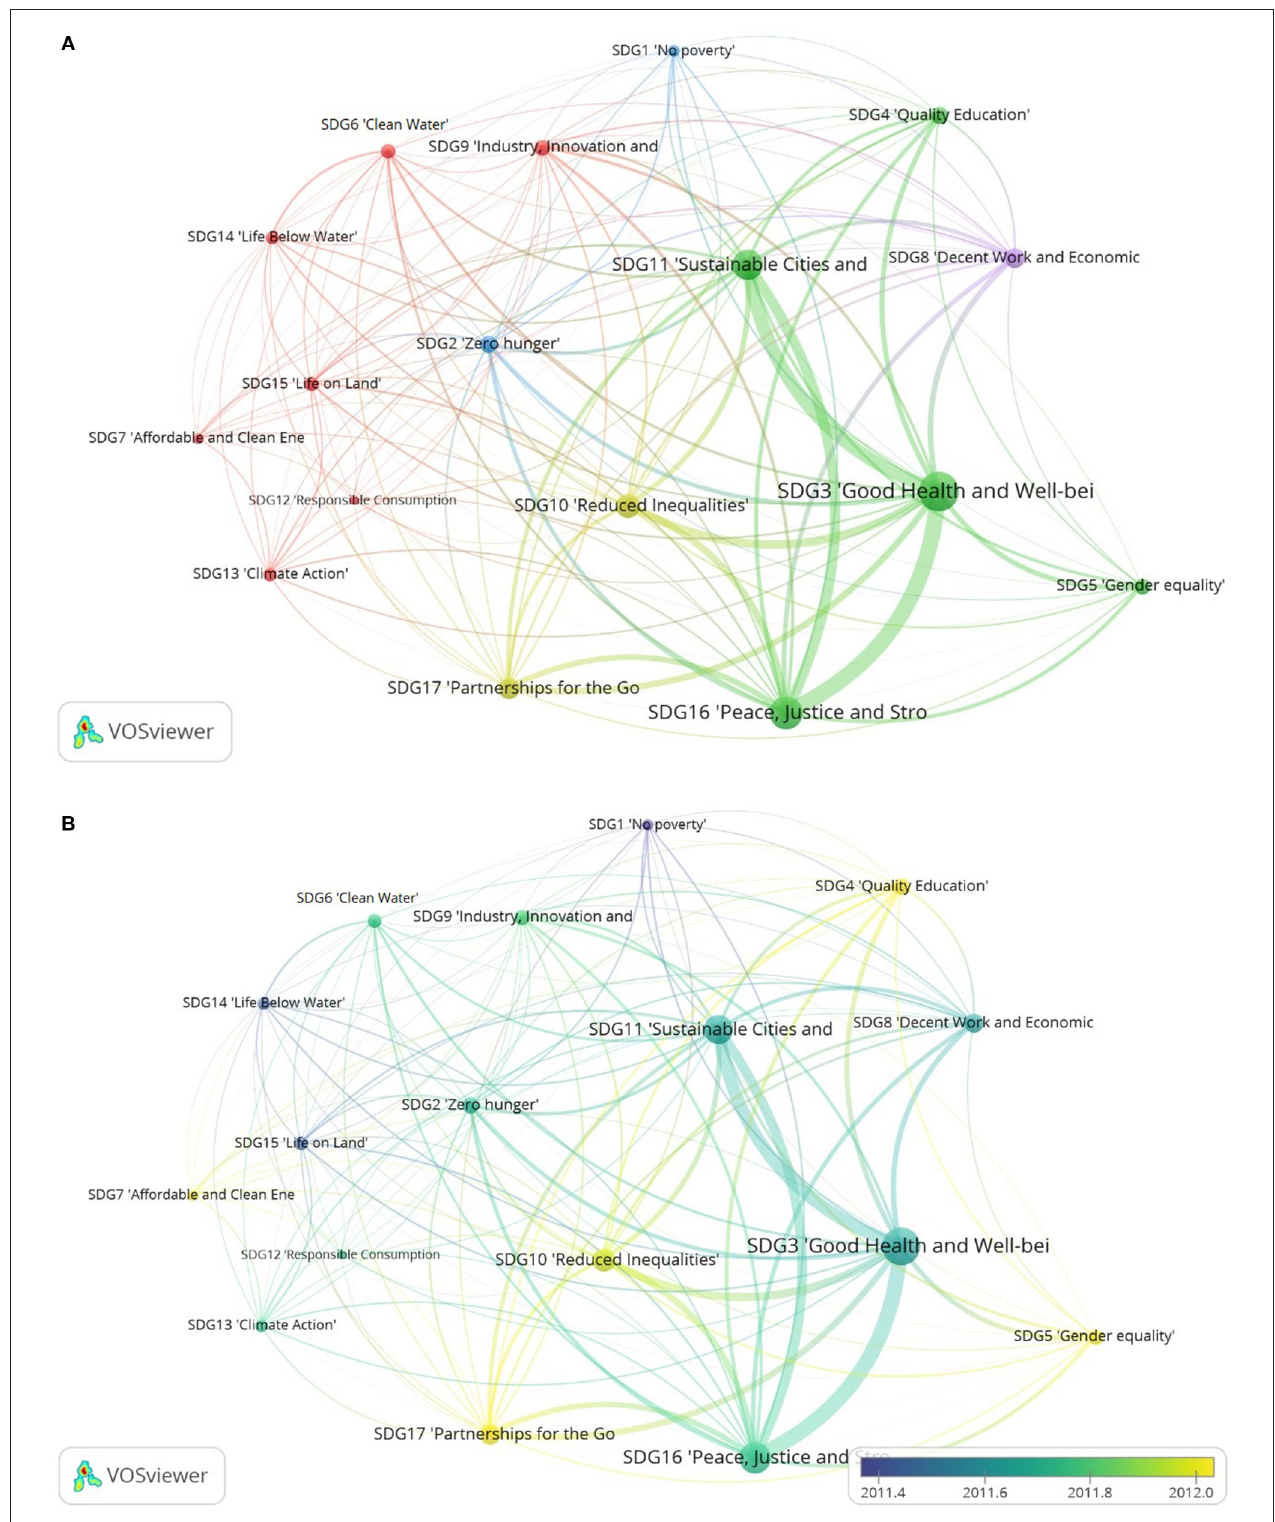
FIGURE 7 | Co-citation occurrence map of (A) M&SDGs research, and (B) average publication year.